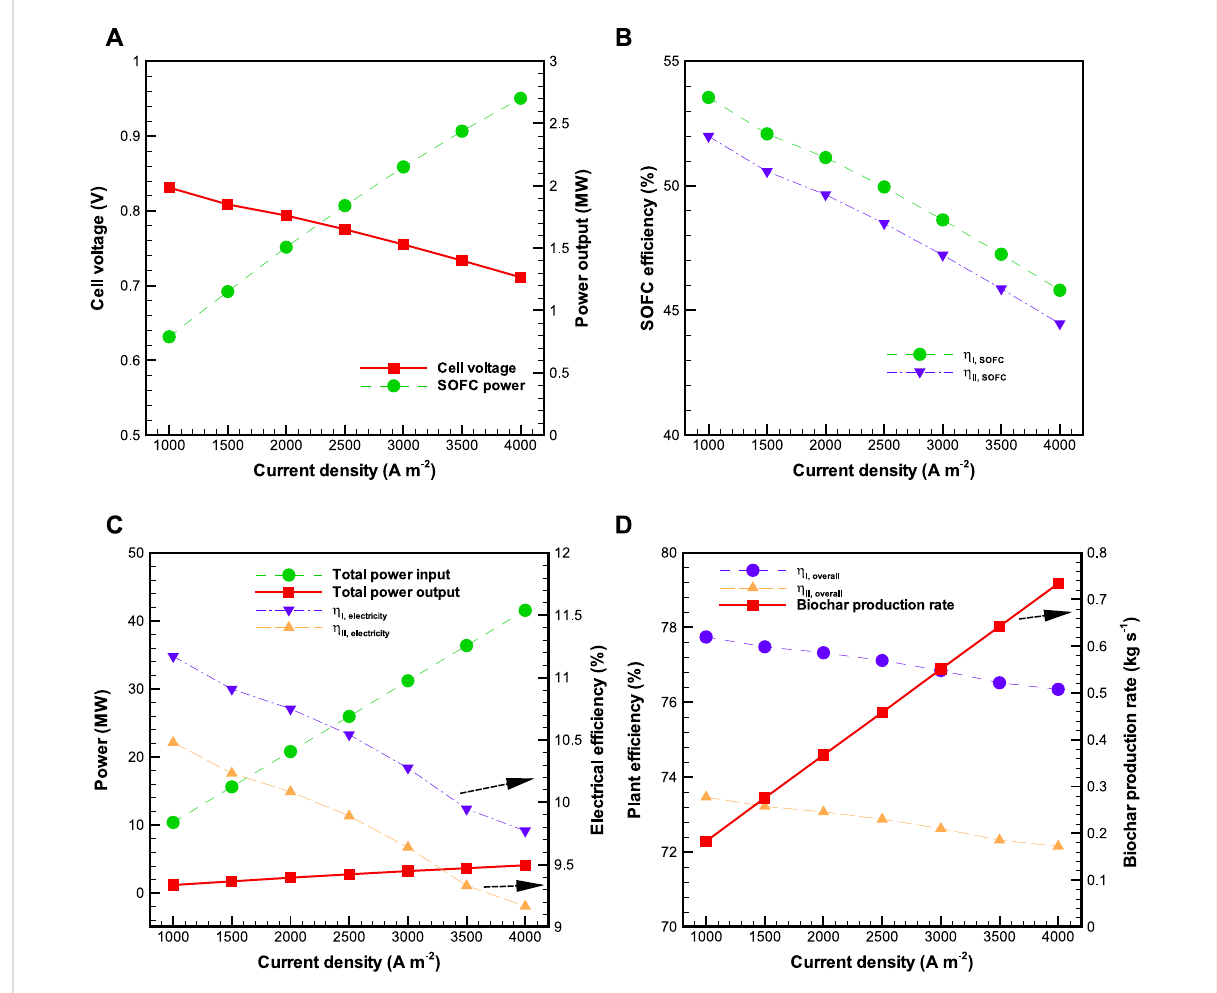
FIGURE 4 Effects of current density ( j ) on the BP-SOFC-CHP system: (A) SOFC cell voltage and power output, (B) SOFC ef fi ciency, (C) total power input and output and electrical ef fi ciency, and (D) overall system ef fi ciency and biochar production